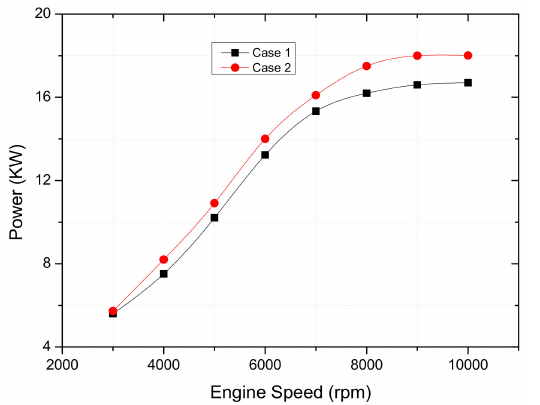
Figure 12. Comparison of engine power between the original and new valve